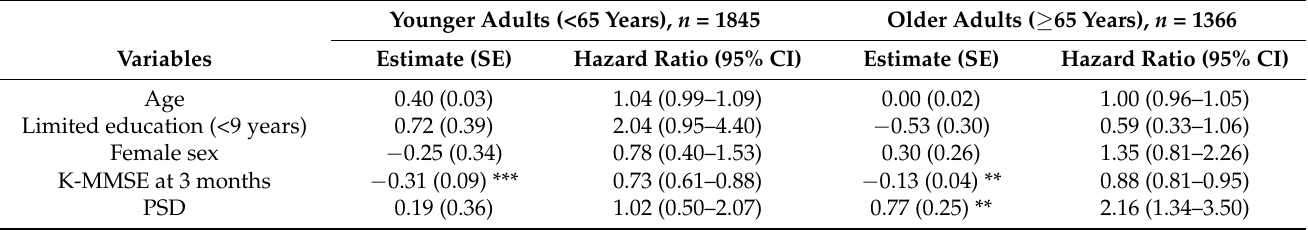
Table 3. The hazard ratios of PSD adjusted for background variables by age group.